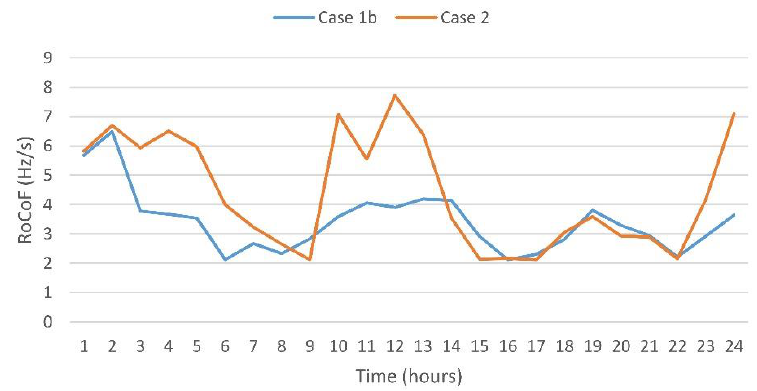
Figure 14. Comparison of RoCoF between Cases 1b and 2.